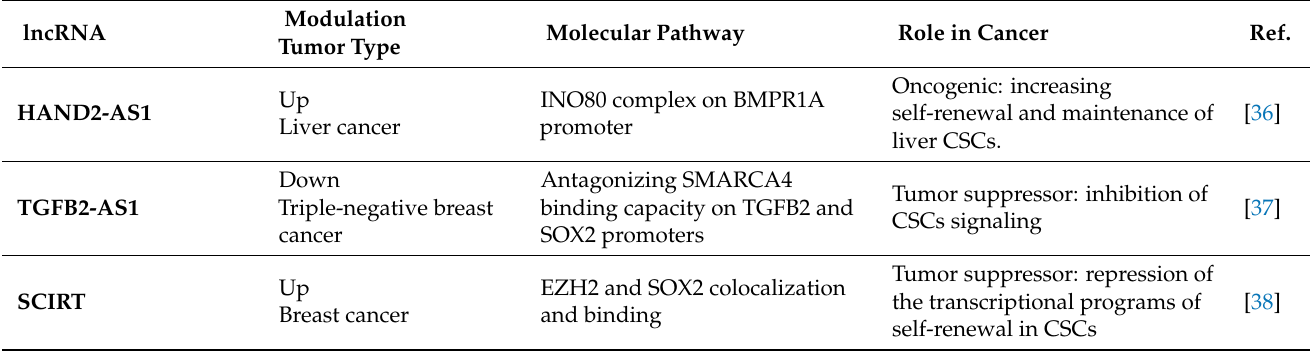
Table 1. LncRNAs working in the nucleus, through the interaction with epigenetic or transcription